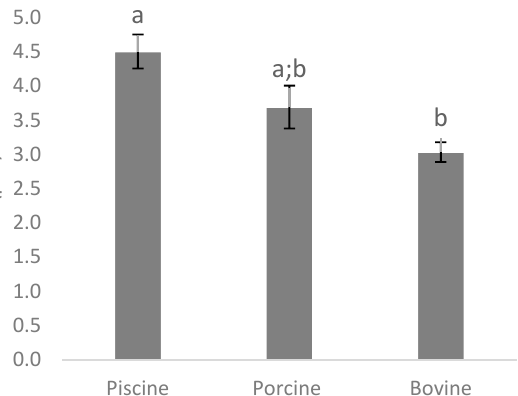
Figure 4. Roughness values of bioplastic surfaces generated from porcine, piscine, and bovine gelatine. Values represent an average of n = 3; error bars represent standard deviation with different lowercase letters representing significantly different values.